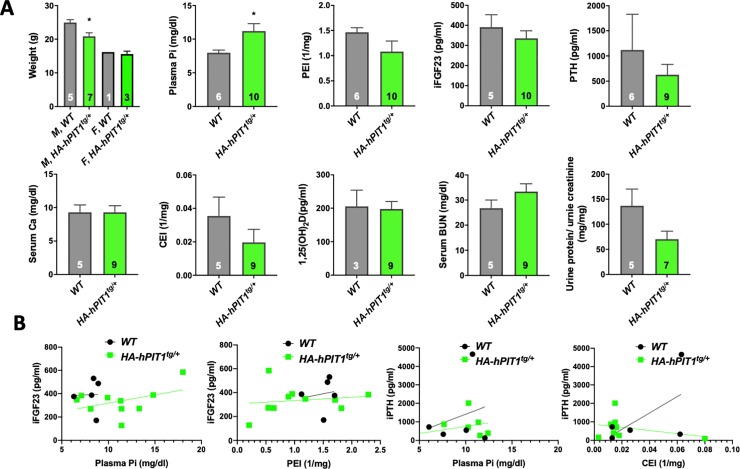
Effect of HA-hPIT1 overexpression on biochemical parameters.Biochemical parameters were determined in 80 day old mice and show aside from hyperphosphatemia no significant differences of means (A) and linear regression analysis (B) between WT and HA-hPIT1tg/+ mice. Means±SEM, n indicated by numbers inside bars, *p = 0.03 vs. WT.